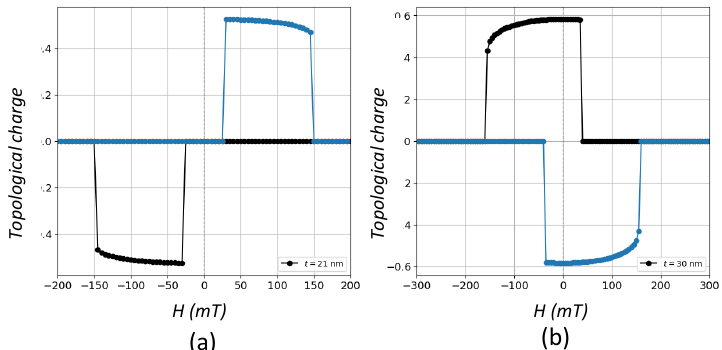
Figure 7. Field dependence of the topological charge for a prism with L = 45 nm for ( a ) t = 21 nm and ( b ) t = 30 nm. Regions where values are close to 0.5 are those where the vortices dwell. Black circles stand for the decreasing field branch of the hysteresis loop and blue circles stand for the increasing field